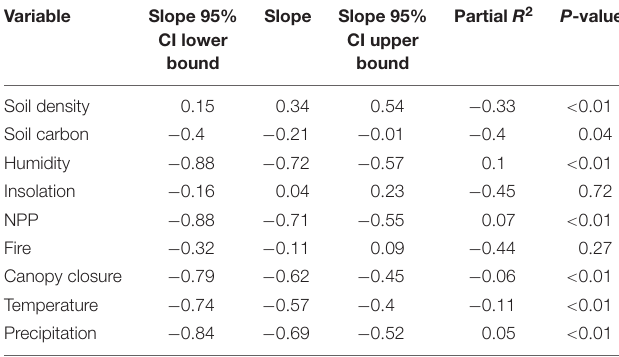
TABLE 2 | Results of univariate regression